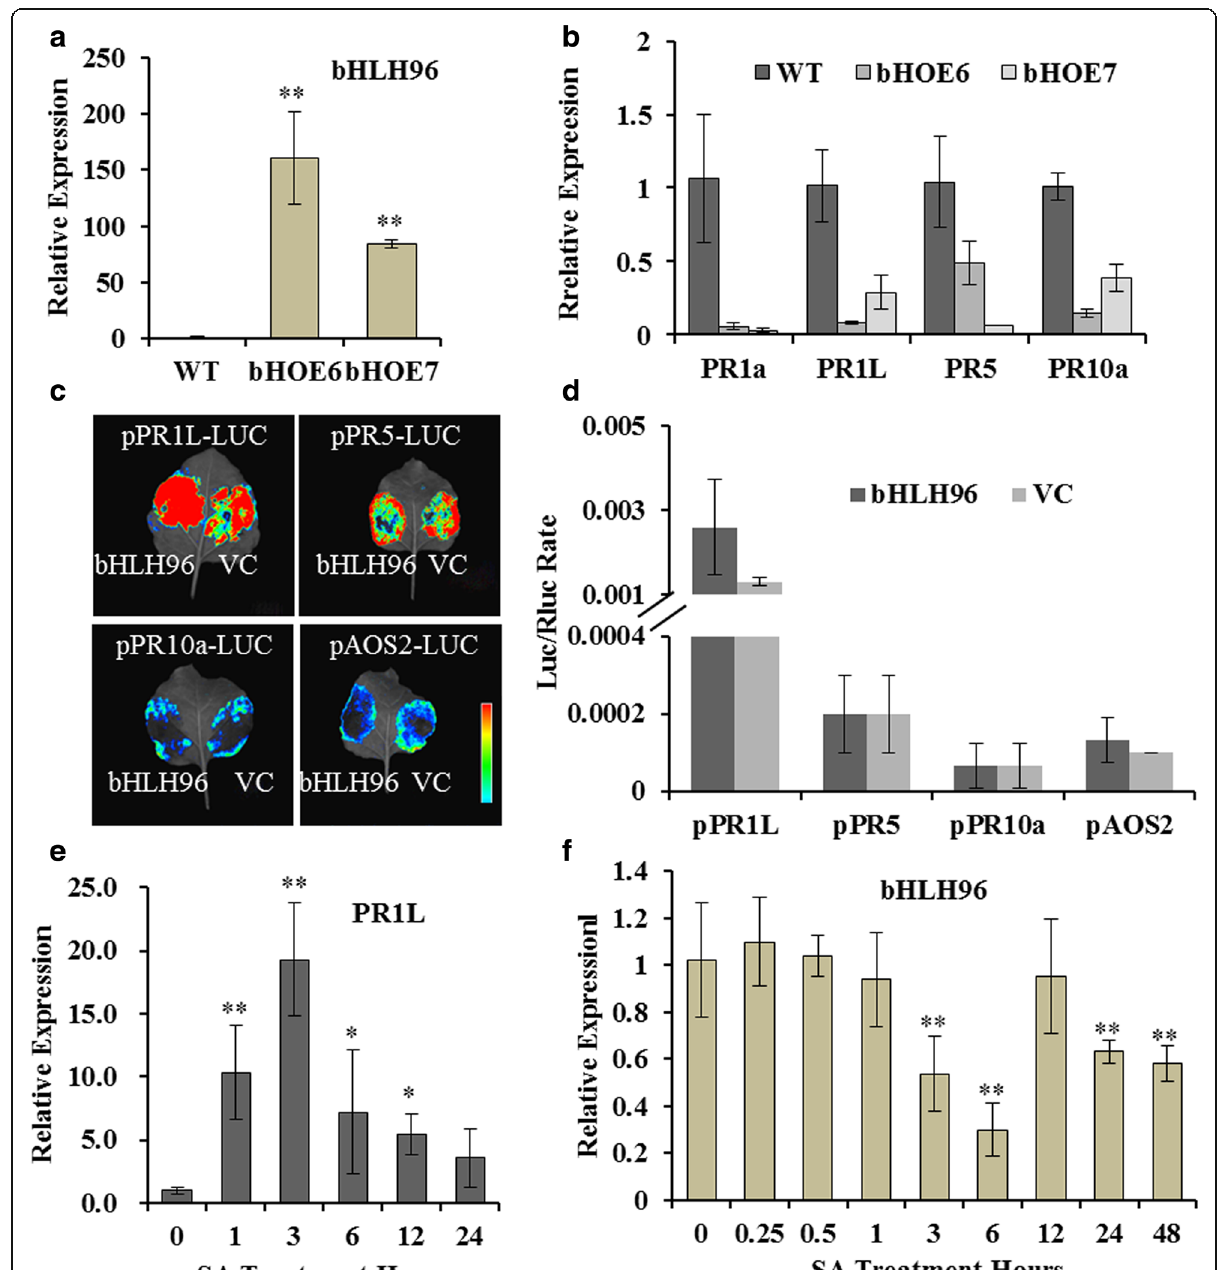
Fig. 6 OsbHLH96 regulated the transcriptional levels of some PR genes. a qRT-PCR analysis of the OsbHLH96 transcripts in the OsbHLH96 over- expressing lines (bHOE) and the WT. b Expression levels of some PR gene transcripts in the OsbHLH96 over-expressing lines. c Dual-Luc assay of the OsbHLH96 and the promoters of PR genes. P, promoter, VC, Vector control. d Quantitative test of Luc/Rluc ratio. e Expression levels of the PR1L transcripts after SA treatment; f Expression levels OsbHLH96 transcripts after SA treatment. Asterisks represent significant differences determined by Student ’ s t-test at * P < 0.05 and ** P < 0.01, n =